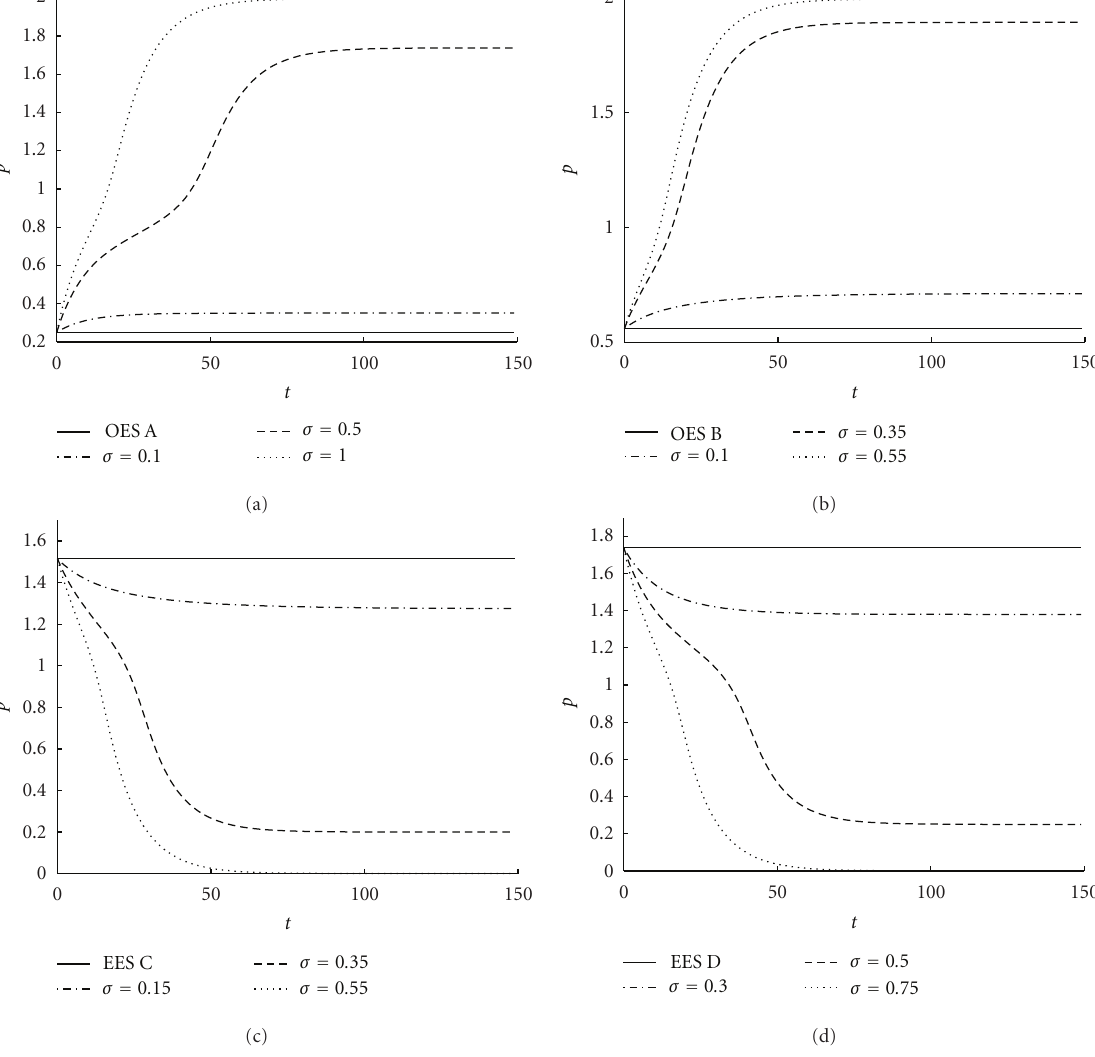
Figure 4: The 15-year nonlinear evolution of the lake ecosystem, with the basic state as the initial condition and c + CNOP-P as the control parameter. (a) c = 0 . 25, the basic state is OES A; (b) c = 0 . 55, the basic state is OES B; (c) c = 0 . 55, the basic state is EES C; (d) c = 0 . 75, the basic state is EES